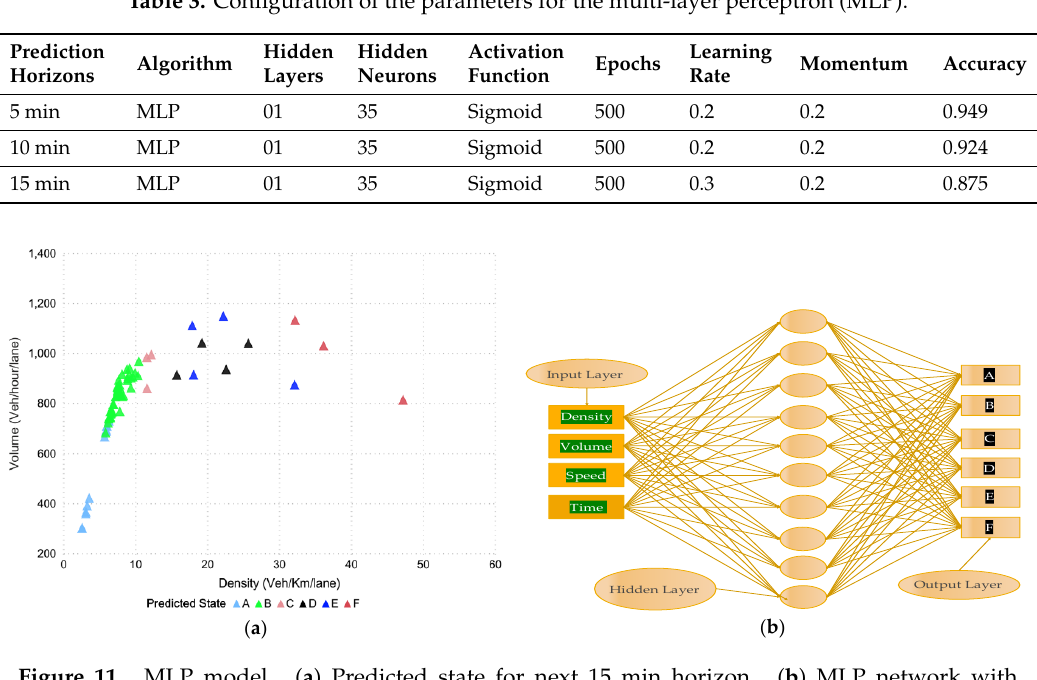
Table 2. CN2 rule setting parameter values.